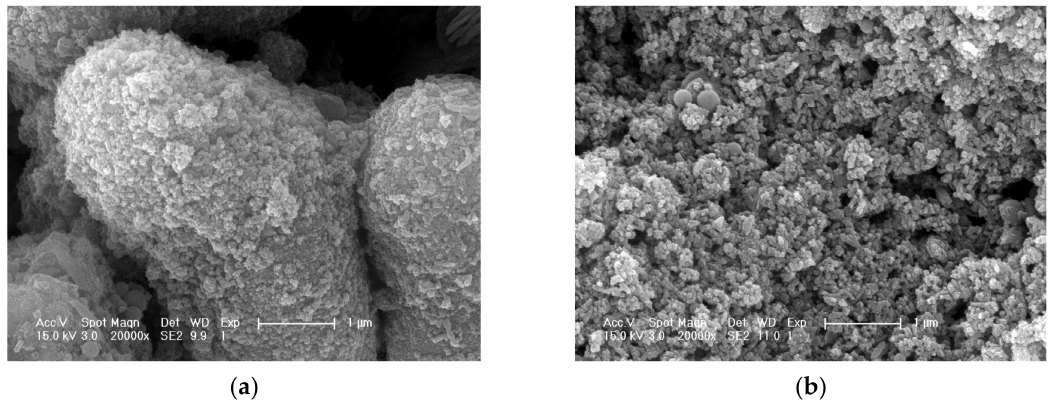
Figure 2. Nano titanium dioxide (TiO 2 ): ( a ) before adding dispersant; ( b ) after adding